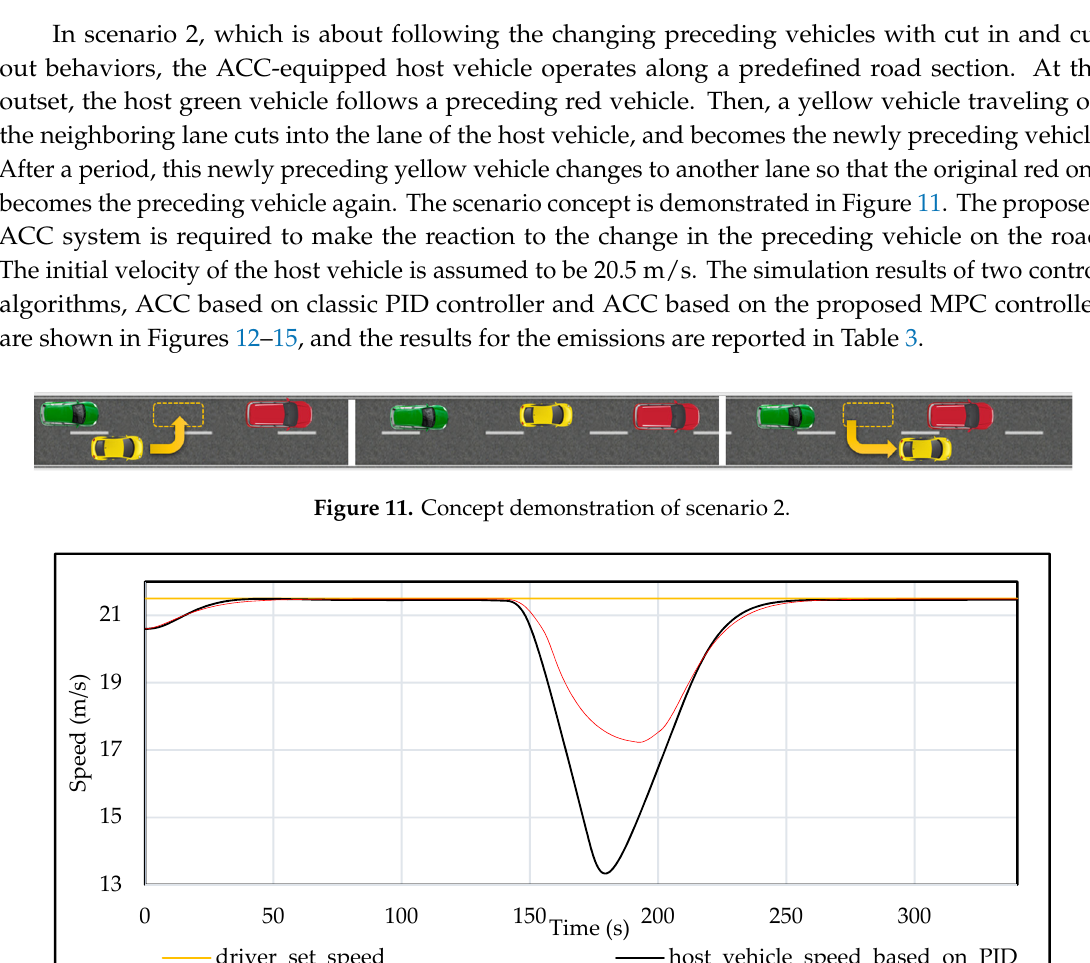
Figure 11. Concept demonstration of scenario 2 . Figure 10. Fuel economy in scenario 1. Figure 10. Fuel economy in scenario 1.